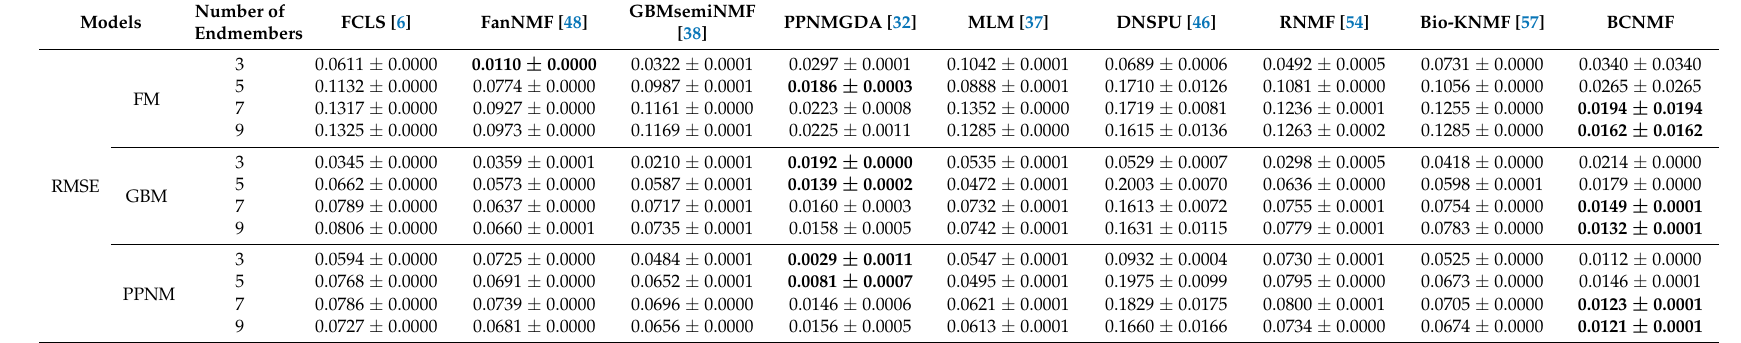
Table 3. Root mean square errors (RMSEs) of all algorithms with different numbers of true endmembers (supervised).